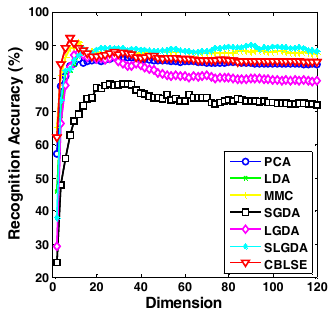
Figure 12. Recognition rate (%) versus dimension of different methods on the COIL20 database.